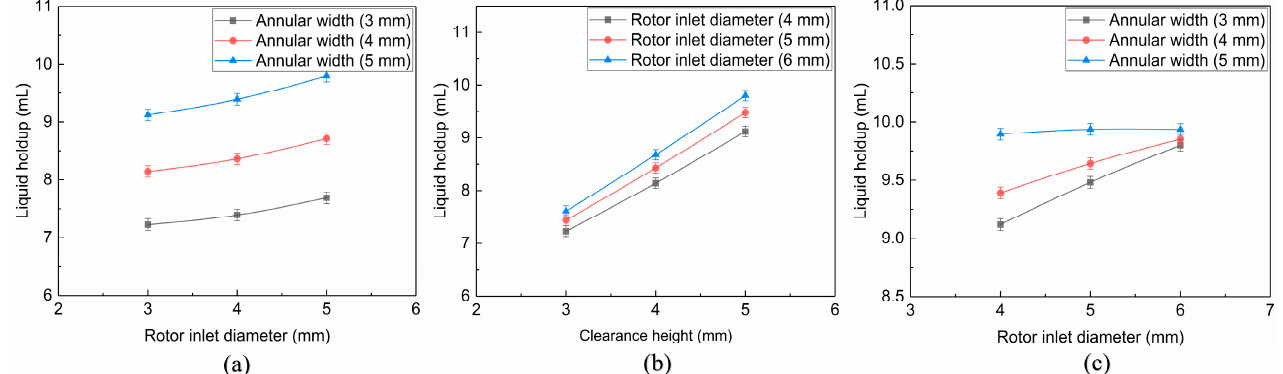
Figure 4. Variation in annular liquid height under different ( a ) annular widths with rotor inlet diameter of 6.0 mm; ( b ) clearance heights with annular width of 3.0 mm; ( c ) rotor inlet diameters with clearance height of 5.0 mm.